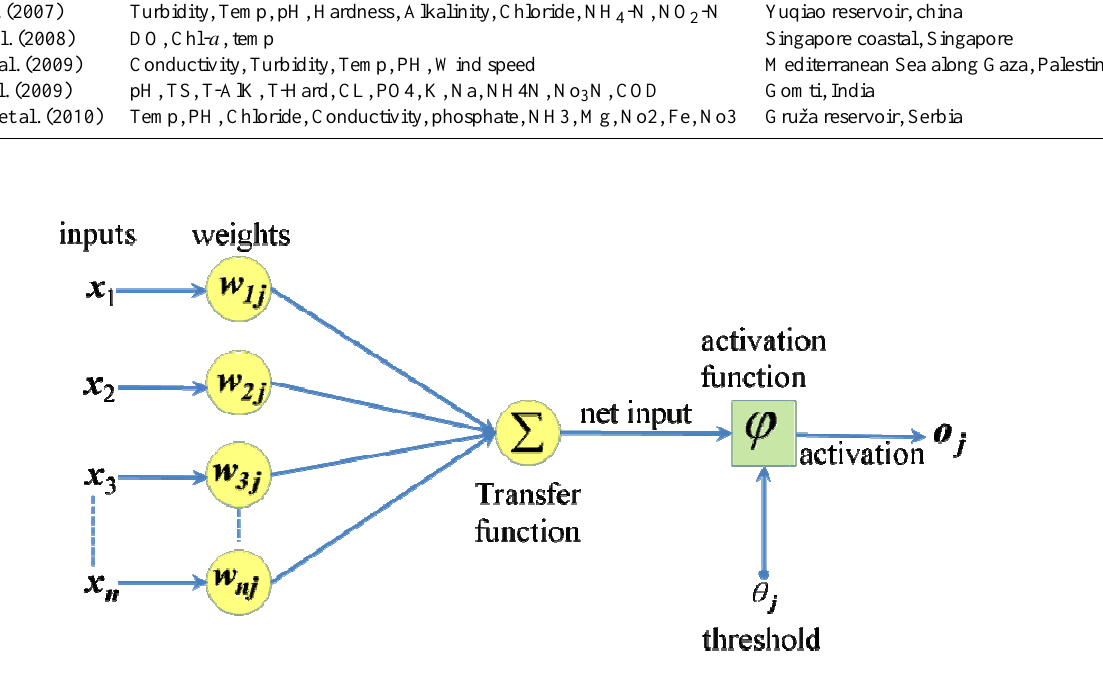
Fig. 2. A typical multi-layer perceptron neural network Fig. 2: A typical multi ypical multi-layer perceptron neural network architecture layer perceptron neural network architecture